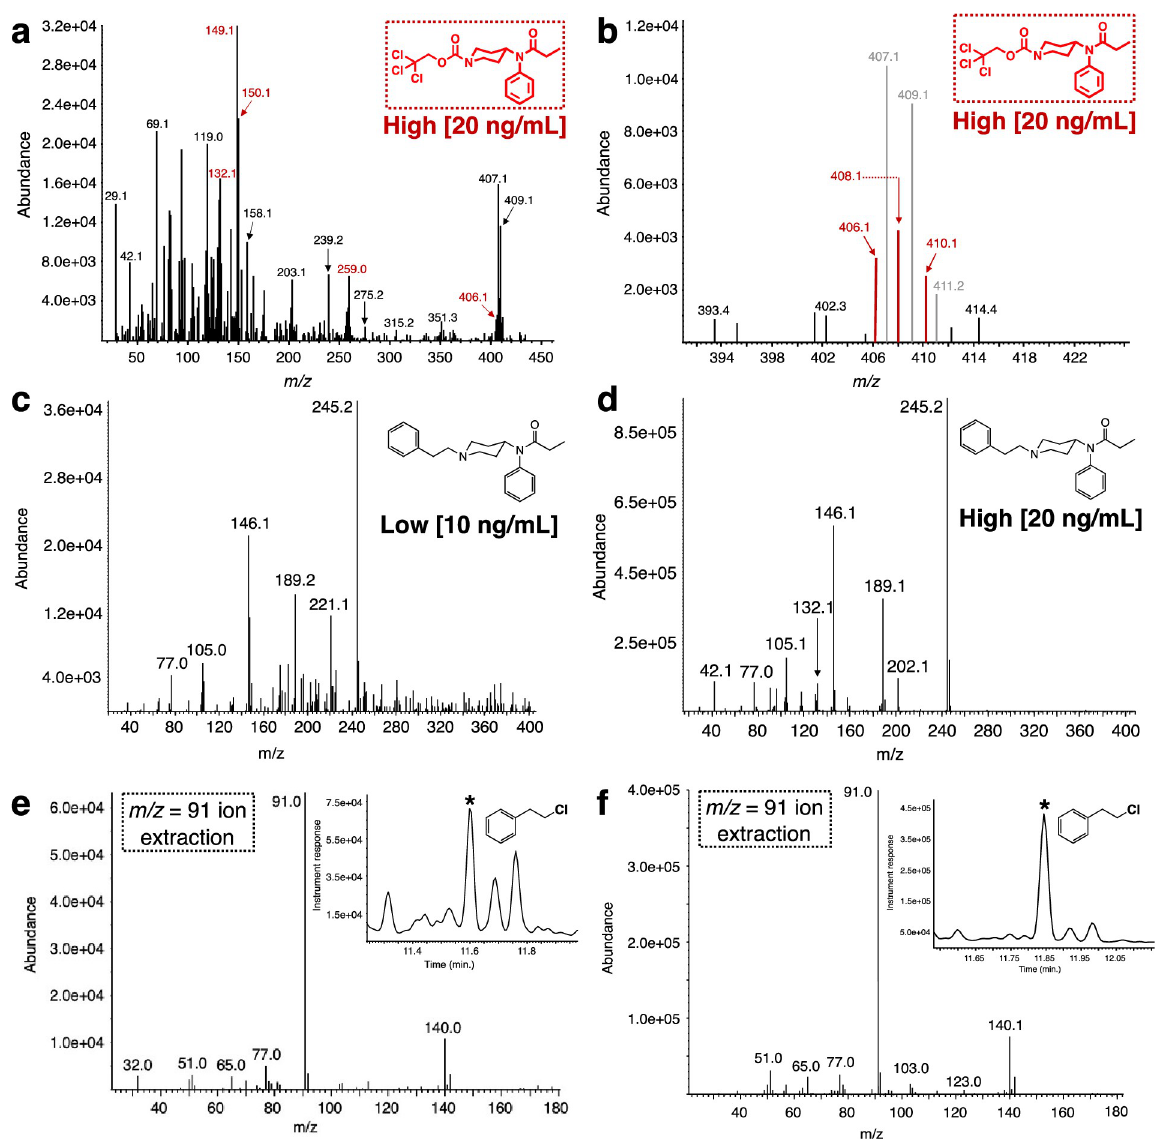
Fig 4. Mass spectral data associated with the reaction between fentanyl-spiked plasma matrices with Troc-Cl. Mass spectra for (a) Troc- norfentanyl product arising from the treatment of fentanyl-spiked plasma extract (20 ng/mL) with Troc-Cl, note that the spectrum is complex and it is the result of an additional Troc-containing interference (Troc-norfentanyl peaks indicated in red); (b) Expansion of the molecular ion peak region for Troc-norfentanyl where the peaks arising from our product are highlighted in red and those from the Troc-containing interference are in gray; mass spectra for (c) extracted fentanyl when spiked at 10 ng/mL and (d) extracted fentanyl when spiked at 20 ng/mL; (e) mass spectrum for 2-phenylethyl chloride for the lowest fentanyl concentration spike and (f) for the highest fentanyl